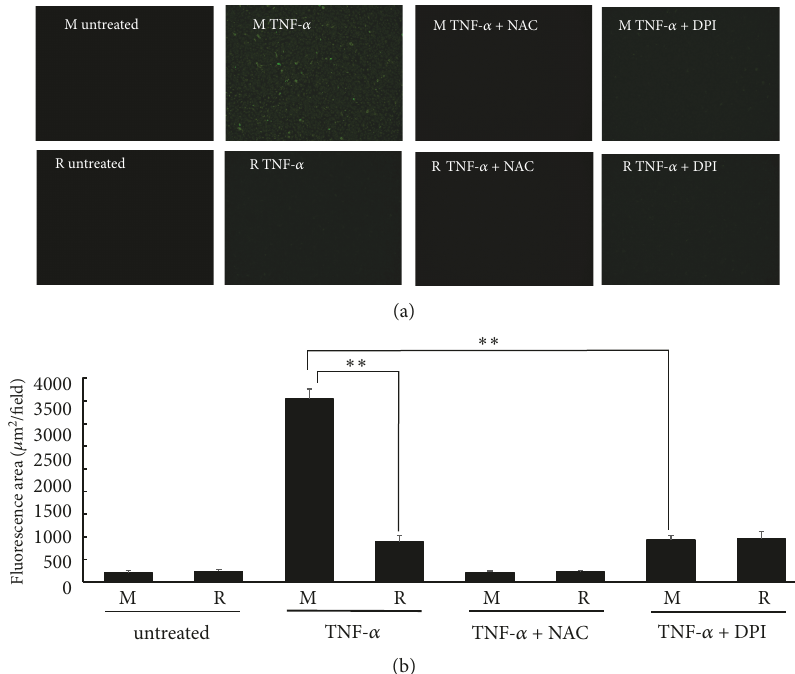
Figure 5: Change in intracellular ROS amount by TNF- 𝛼 stimulation. Each cell line was treated with 20ng/mL TNF- 𝛼 for 4 h and stained using CellROX (cid:3) Green. (a) Cells were photographed with fluorescence microscopy (40 × magnification). (b) A fluorescent images were taken and digitized using ImageJ. M: mock cells; R: TERT HUVEC R cells. n=3; ∗∗ p < 0.01.